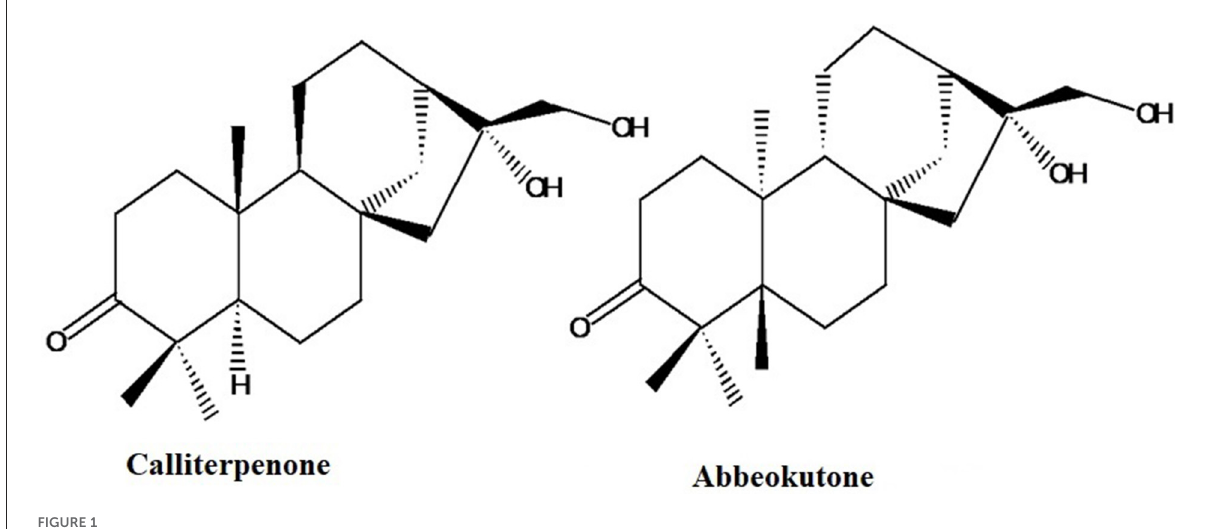
FIGURE1 Structure of calliterpenone and